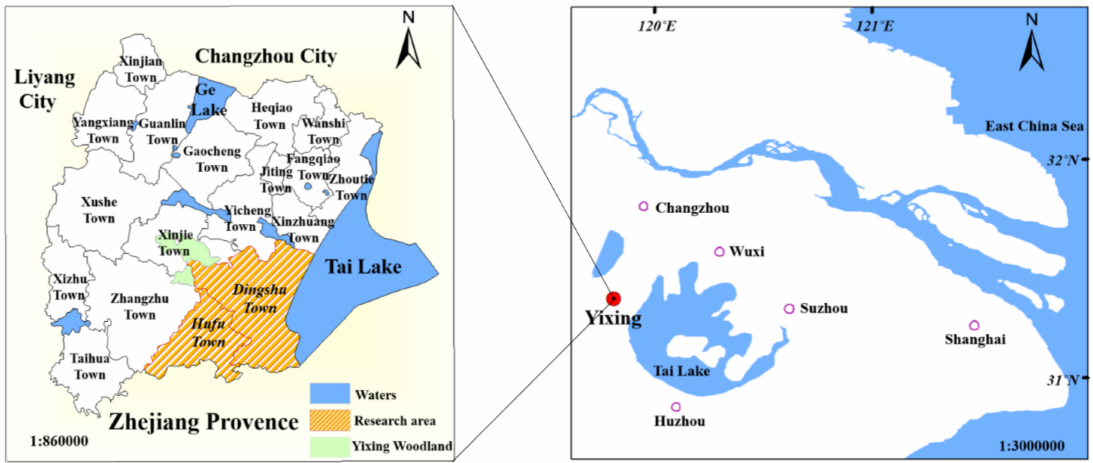
Figure 1. Location of study area.